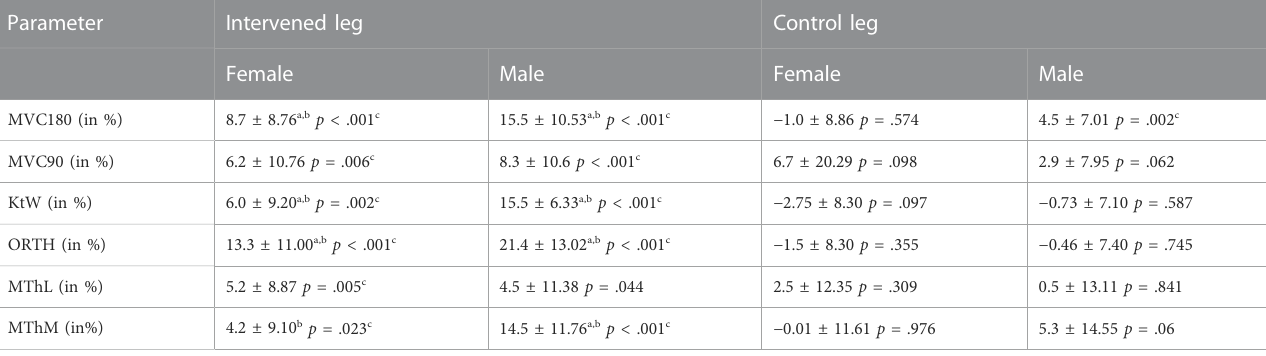
TABLE 2 Post-test percentage values of included parameters in relationship to the pre-test 100%.